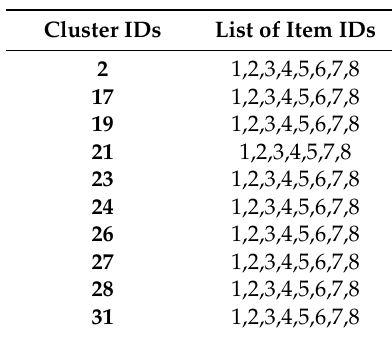
Table 4. List of item IDs contained in the